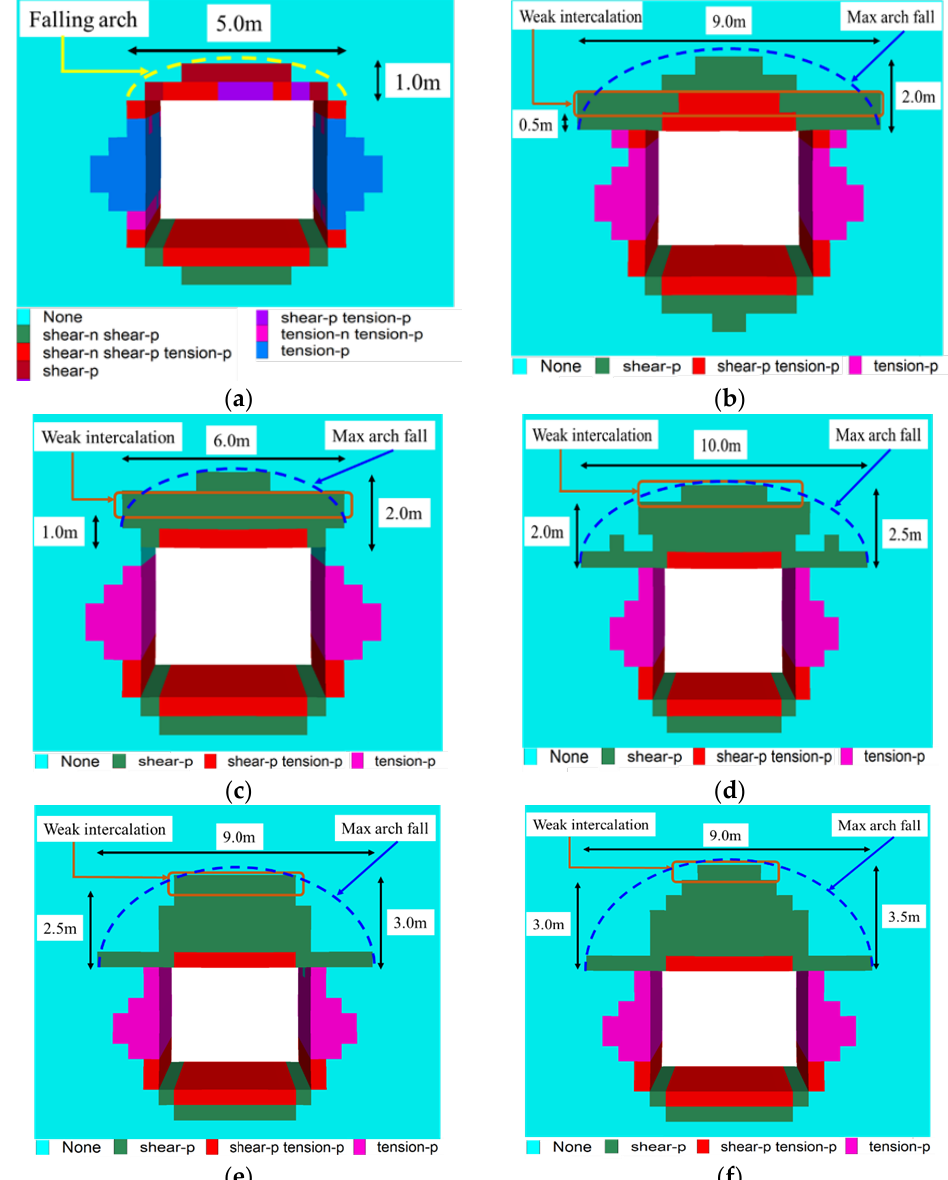
Figure 5. Distribution of the Plastic Zone of the Roof Layer. ( a ) Contrast model. ( b ) Scheme I. ( c ) Scheme II. ( d ) Scheme III. ( e ) Scheme IV. ( f ) Scheme V.